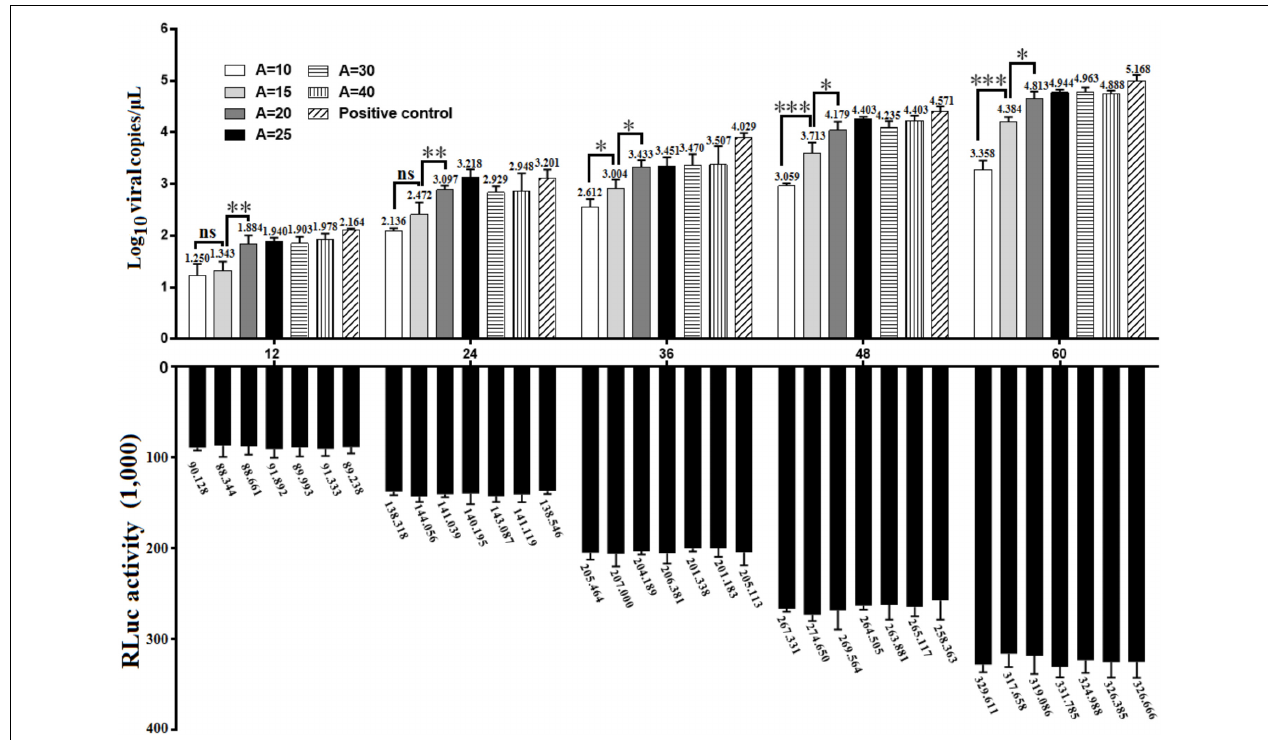
FIGURE 3 | Growth characteristics of DHAV-1 with various length of poly(A) tail. 0.8 µ g of in vitro transcribed product of pR-DHAV-3 (cid:48) UTR-An were transfected into DEFs, cell lysates were collected from 12 to 60 hpt and were immediately used for total RNA extraction. Viral growth characteristics were measured by RT-qPCR as previously described. Bars represent the mean ± S.D of three replicate experiments for each group. 0.1 µ g of pGMLR-TK plasmid was co-transfected with RNA samples, and the RLuc activity was measured at each detection point. ∗ P < 0.05, ∗∗ P < 0.01, ∗∗∗ P < 0.001, ns represent P >